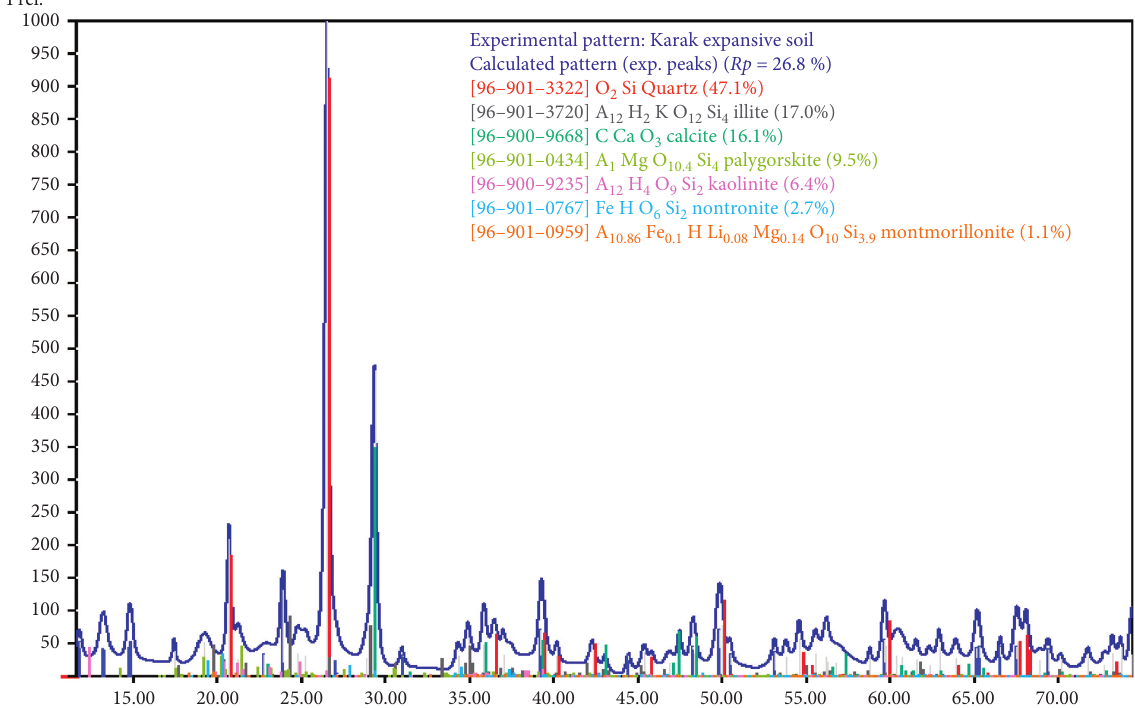
Figure 6: X-ray diffractogram of Karak expansive soil produced in